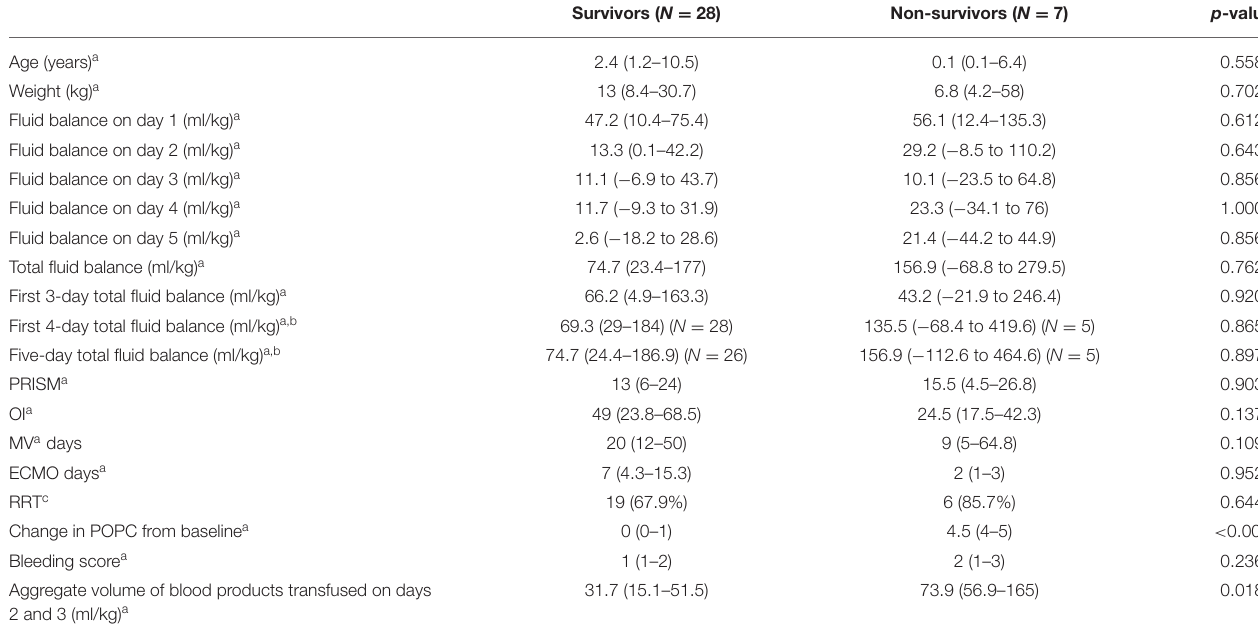
TABLE 3 | Comparison of risk factors and outcomes between survivors vs. non-survivors in the VV-ECMO (venovenous extracorporeal membrane oxygenation)